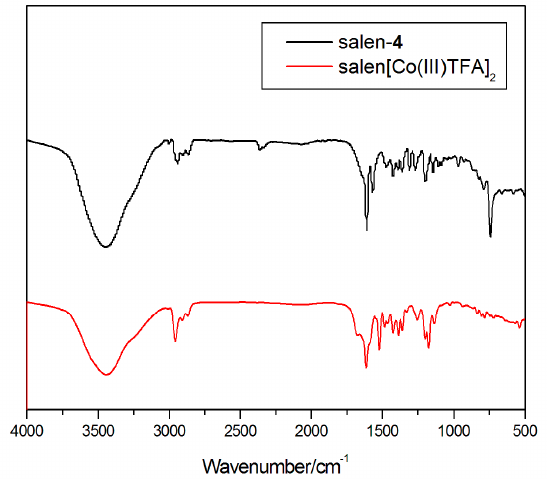
Figure 2. IR of ligand salen- 4 and complex (salen- 4 )[Co(III)TFA] 2 .